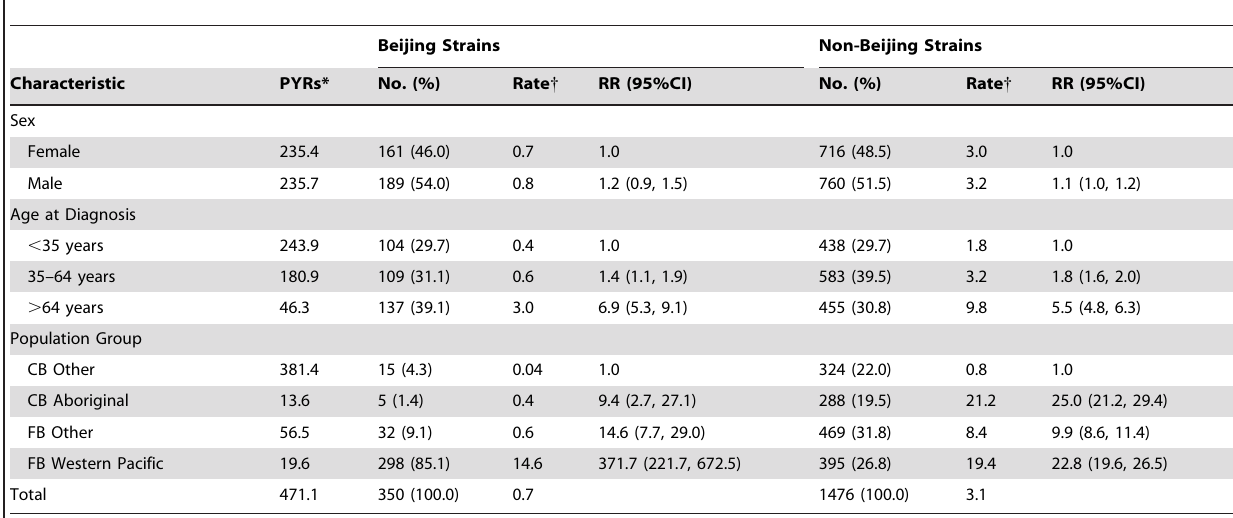
Table 1. Incidence of Beijing and Non-Beijing strains of M. tuberculosis in Alberta,